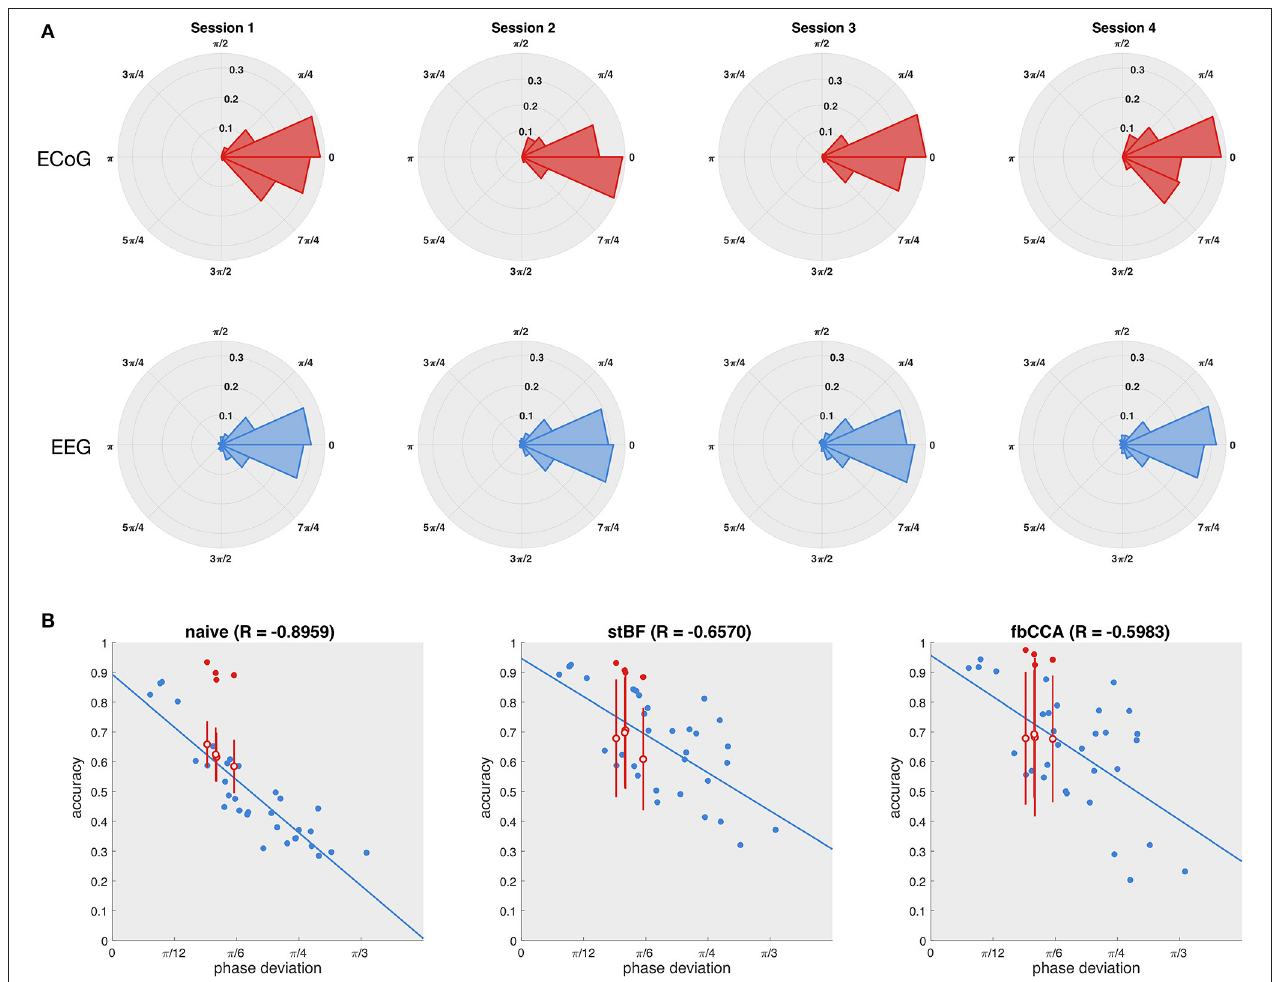
FIGURE 3 | Estimation of the patient’s scalp-EEG accuracy. (A) Distribution of the phase deviation at the stimulation frequency across trials of the ECoG (left column) and scalp-EEG (right column) for the four sessions (rows). Kuiper’s test did not reveal any significant differences between the ECoG and scalp-EEG phase deviation distributions for any of the four sessions. (B) Regression of accuracy on phase deviation. Each dot represents one session of one subject. Blue dots indicate the control subjects, red filled dots indicate the patient, and red open dots indicate the statistically estimated scalp-EEG accuracy of the patient with the vertical red line the corresponding standard deviation for 100